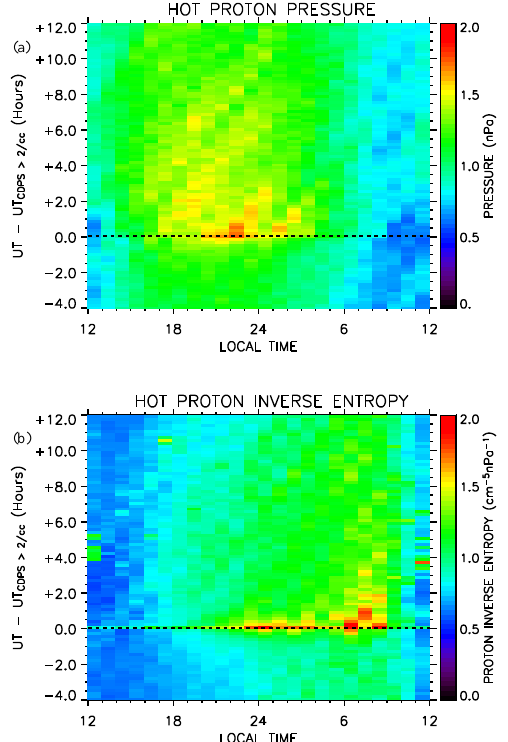
Fig. 3. Results of the superposed epoch analysis for various plasma parameters, similar to Fig. 2. (a) Superposed epoch plot of the ion pressure. (b) Superposed epoch plot of the inverse entropy (based on ion measurements). Respective color palettes are given on the right side of each plot. See text for further